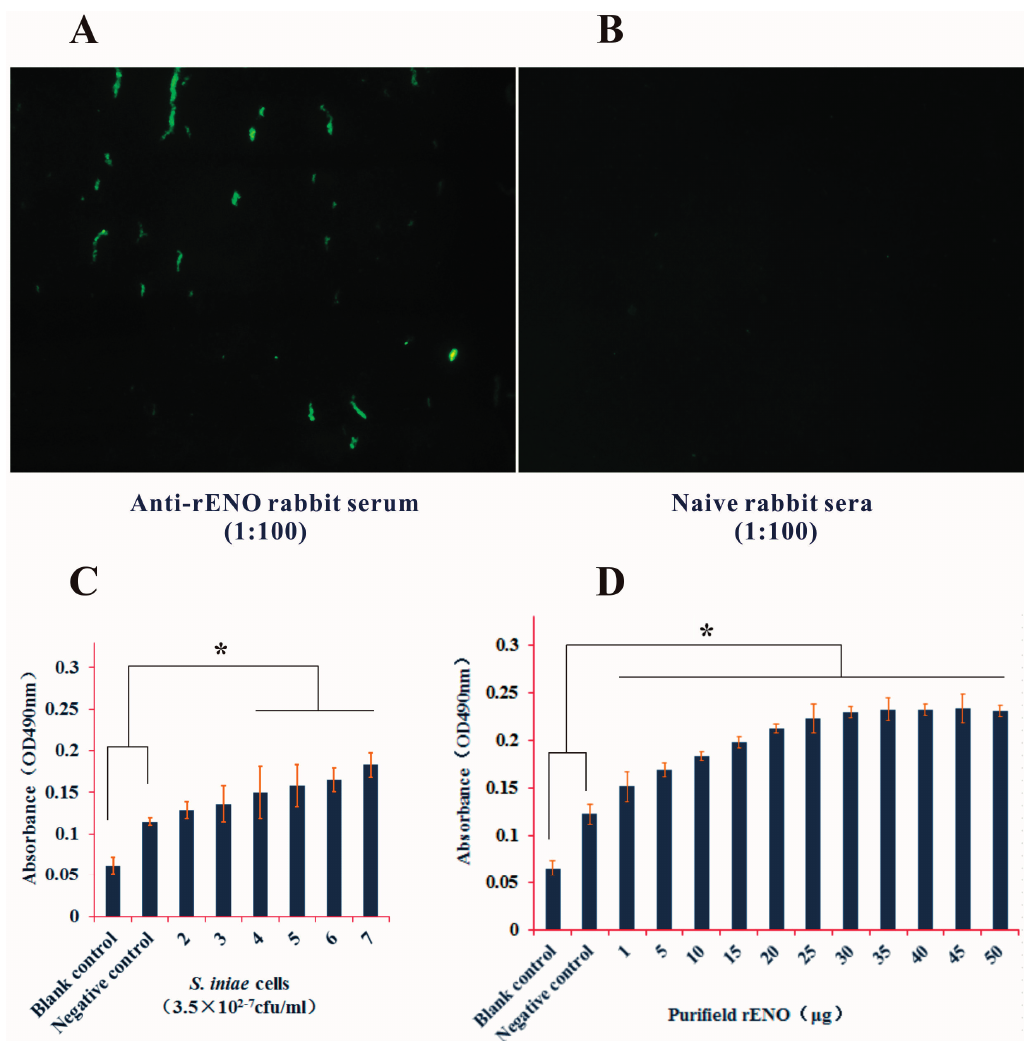
Figure 3. Identification of S. iniae α -enolase expression on the cell surface. ( A , B ) Indirect immunofluorescence analysis of cell surface α -enolase was carried out with rabbit anti-rENO serum (1:100) or PBS. The fluoresced bacteria cells were showed in chain cocci when bacteria cells were observed by fluorescence microscopy after incubated with FITC conjugated goat anti-rabbit antibody (1:64) and (panel A ), but the naive rabbit sera control was not observed (panel B ); ( C ) Rabbit anti-rENO serum was used to detect the surface α -enolase of S. iniae by ELISA. The data showed that the absorbance value (OD 450 nm) increased with the bacteria cells concentration, and the higher concentration bacteria (3.5 × 10 4 − 6 cfu/mL) were significant difference compared with negative control ( p < 0.05); ( D ) Rabbit anti- S. iniae whole-cell serum was prepared by our laboratory with formalin inactivated S. iniae . The absorbance of rENO incubated with anti- S. iniae serum were significant higher than the control incubated with negative serum or PBS ( p < 0.05). * p < 0.05. Error bars indicate